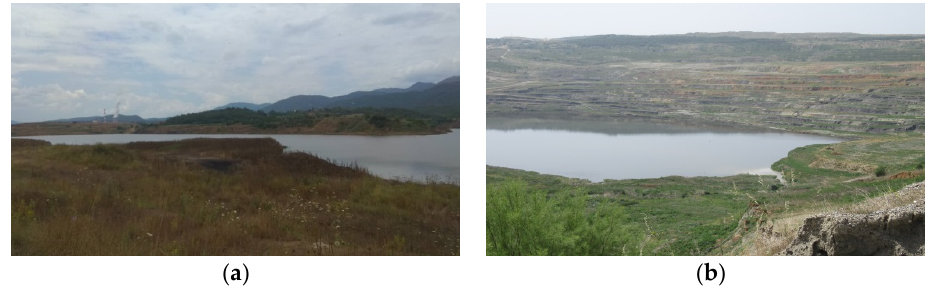
Figure 4. ( a ) Kyparissia pit lake and ( b ) Amynteon pit lake.